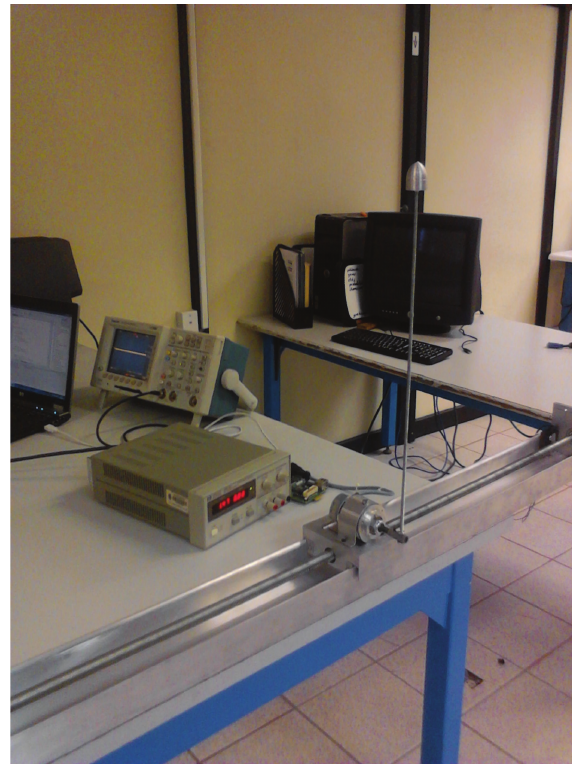
Figure 4: Inverted pendulum